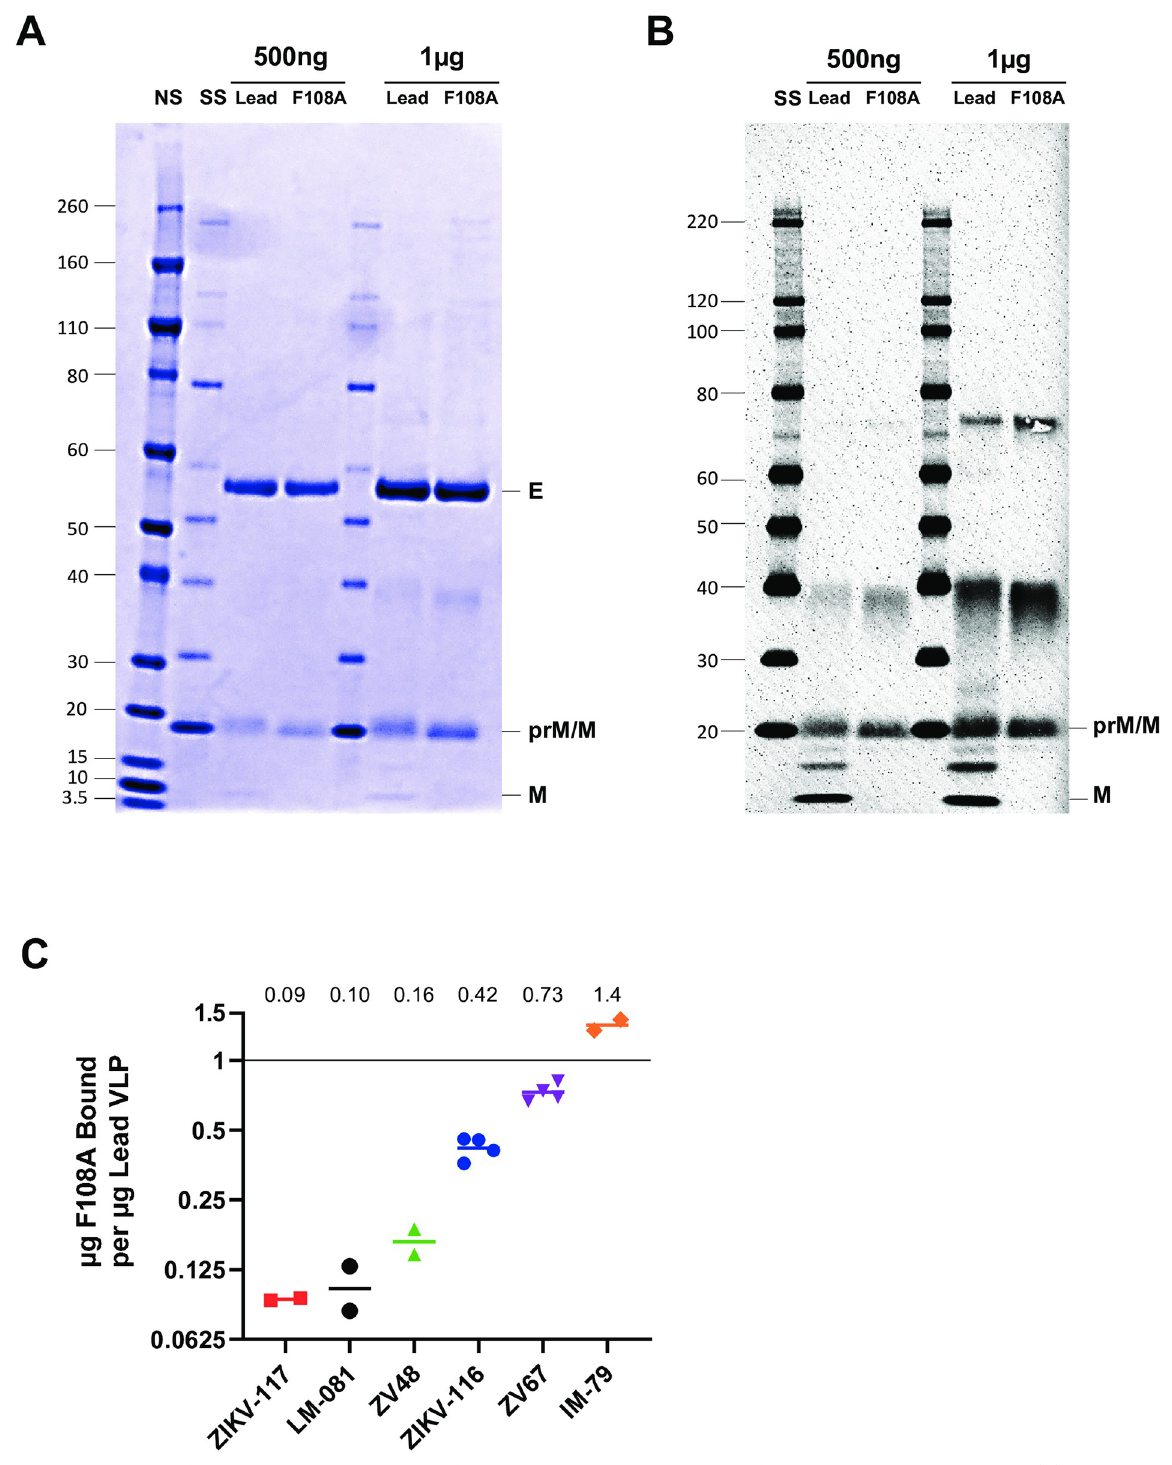
Fig 2. Comparison of the maturation state of lead and F108A particles by prM/M protein detection and E epitope mapping. (A) SDS-PAGE followed by Coomassie protein staining of 500ng and 1 μ g of purified lead and F108A ZIKV VLPs. Molecular weight ladders on this gel are the Novex Sharp (NS; Invitrogen, cat#57318, molecular weights for this ladder shown in kDa) and the Super Signal (SS; Thermo, cat#847868) (B) SDS-PAGE followed by immunoblotting analysis of 500ng and 1 μ g of purified lead and F108A ZIKV VLPs. An anti-prM polyclonal Ab against ZIKV (Genetex, cat#gtx133305) was used to detect VLP proteins. (C) Binding of each mAb to F108A VLP relative to lead VLP measured by Biolayer Interferometry. Binding was measured at 100 seconds (ZIKV-116, ZV67, IM-79), 250 seconds (ZIKV-117, ZV48, LM-081) or both 100